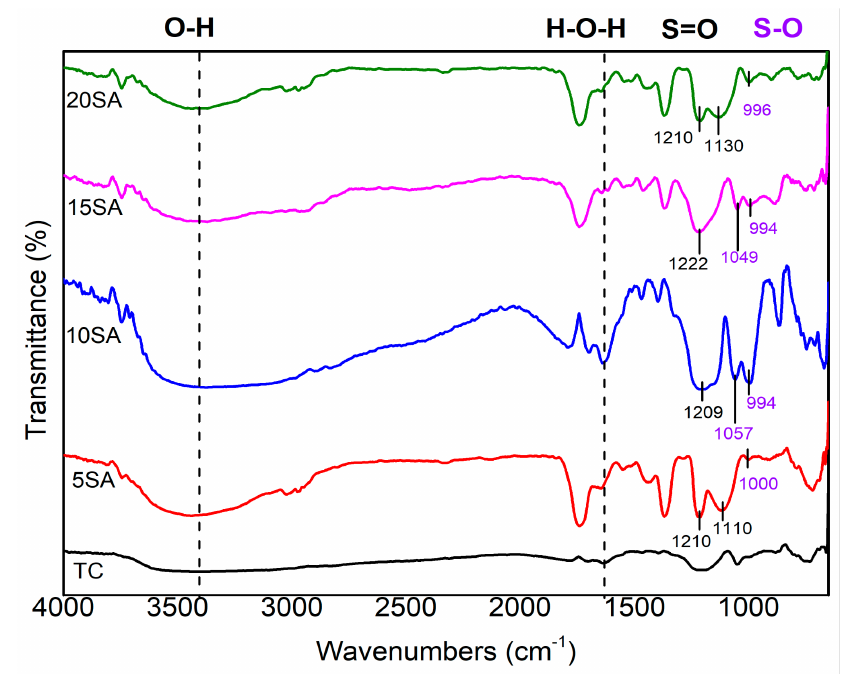
Figure 2. FTIR spectra of non-sulphated and sulphated-titania catalysts at various concentration. The XRD profile of non-sulphated (TC) and sulphated-titania with different concen- trations of sulfuric acid (5SA, 10SA, 15SA, and 20SA) are displayed in Figure 3. The diffraction peaks of TC were detected at 2 θ = 25.3 ◦ , 37.0 ◦ , 37.9 ◦ , 38.7 ◦ , 54.0 ◦ , 55.1 ◦ , 58.1 ◦ , 62.7 ◦ , 68.8 ◦ , 70.3 ◦ , 75.1 ◦ , 76.1 ◦ . These peaks correspond to the anatase phase